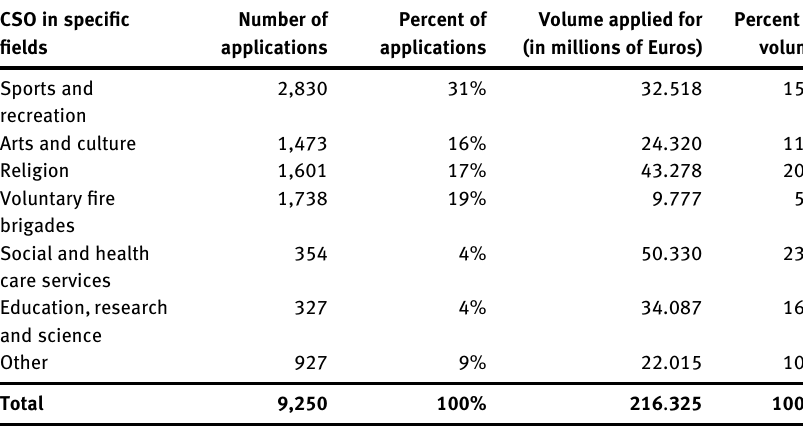
Table  : Applications and volumes applied for in different fi elds by end of September  . CSO in speci fi c fi